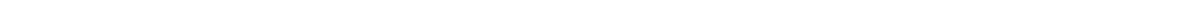
Fig. 2 Interaction peaks at 10q26.13 and 14q13.3 in T-47D, Bre80 and MDA-MB-231 cell lines. Interaction peaks are shown in a looping format; interaction peaks in ZR-75 – 1, BT-20 and GM06990 are not shown but are available online (Methods). Interaction peaks between two captured fragments are red, interaction peaks between one captured fragment and one non-captured fragment are blue. Intensity of individual interactions are proportional to -log 2 (P FDR ). Capture regions are shown as black bars; data are aligned with genomic coordinates (hg19) and RefSeq genes. Target genes (i.e. the subset at which an interaction peak co-localises with the TSS) are shown in red. The location of the published risk SNP is also shown. a 10q26.13-rs2981579 ( FGFR2 ) locus. Interaction peaks originating from the capture region and co-localising with the FGFR2 TSS, interact with a region ~650 kb centromeric to the locus (highlighted in yellow) in T-47D and Bre80, but not MDA-MB-231. b Interaction peaks (shown in blue) at this region co-localise with DNase I hypersensitive sites, CTCF, p300, FOXA1, GATA3 and ER α ChIP-Seq peaks in T-47D cells. The orientation of CTCF peaks is indicated by the direction of the arrow. c 14q13.3-rs2236007 ( PAX9 ) locus. Interaction peaks originating from the capture region and co-localising with the PAX9 TSS, interact with two regions ~300 and 500 kb telomeric to the locus (highlighted in yellow) in T-47D and Bre80, but not MDA-MB-231. Scale bar, 80 kb ( d ) and e Interaction peaks at these regions co-localise with DNase I hypersensitive sites, CTCF, FOXA1 and GATA3 ChIP-Seq peaks in T-47D cells. The orientation of CTCF peaks is indicated by the direction of the